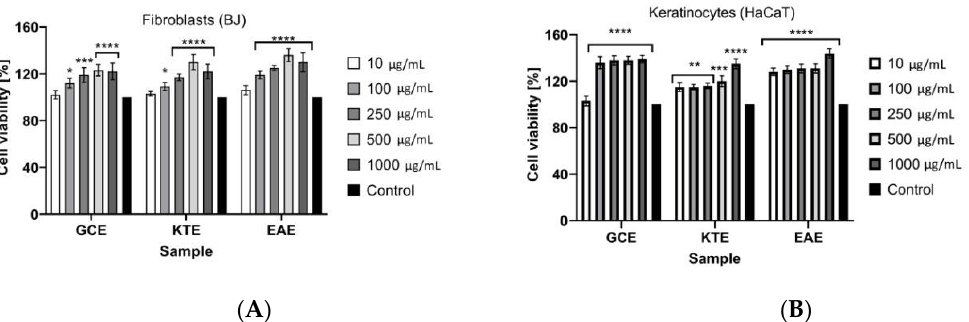
Figure 11. The effect of Centella asiaticaL . (GCE), Clitoria ternatea L. (KTE) and Epilobium angustifolium L. (EAE) (1–1000 μg/mL) on Neutral Red Dye uptake in cultured ( A ) fibroblasts (BJ) and ( B ) keratinocytes (HaCaT) after 24 h of exposure. Data are the mean ± SD of three independent experiments, each of which consists of four replicates per treatment group. For BJ **** p < 0.0001, *** p = 0.0002, * p < 0.0112 versus the control (100%). For HaCaT **** p < 0.0001, *** p = 0.0006, ** p < 0.0084 versus the control (100%).